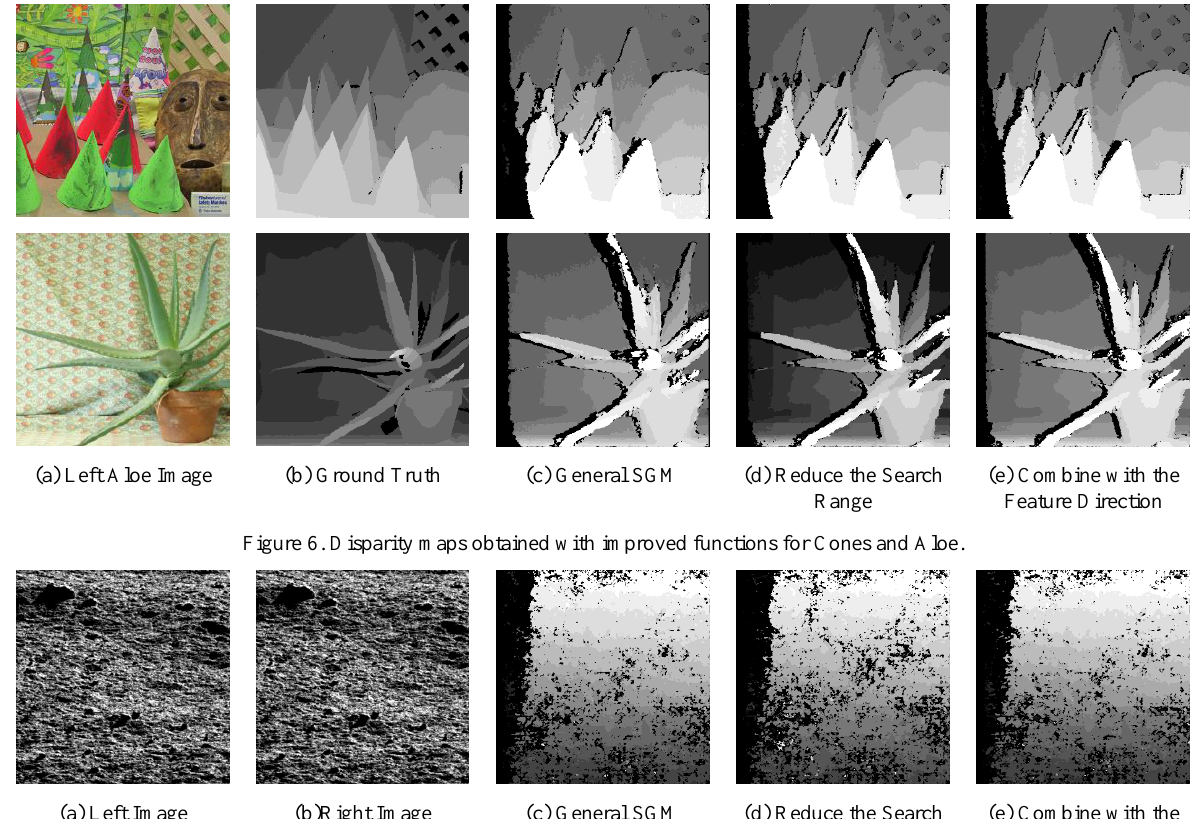
Figure 7. Disparity maps obtained with improved functions for stereo images of the lunar